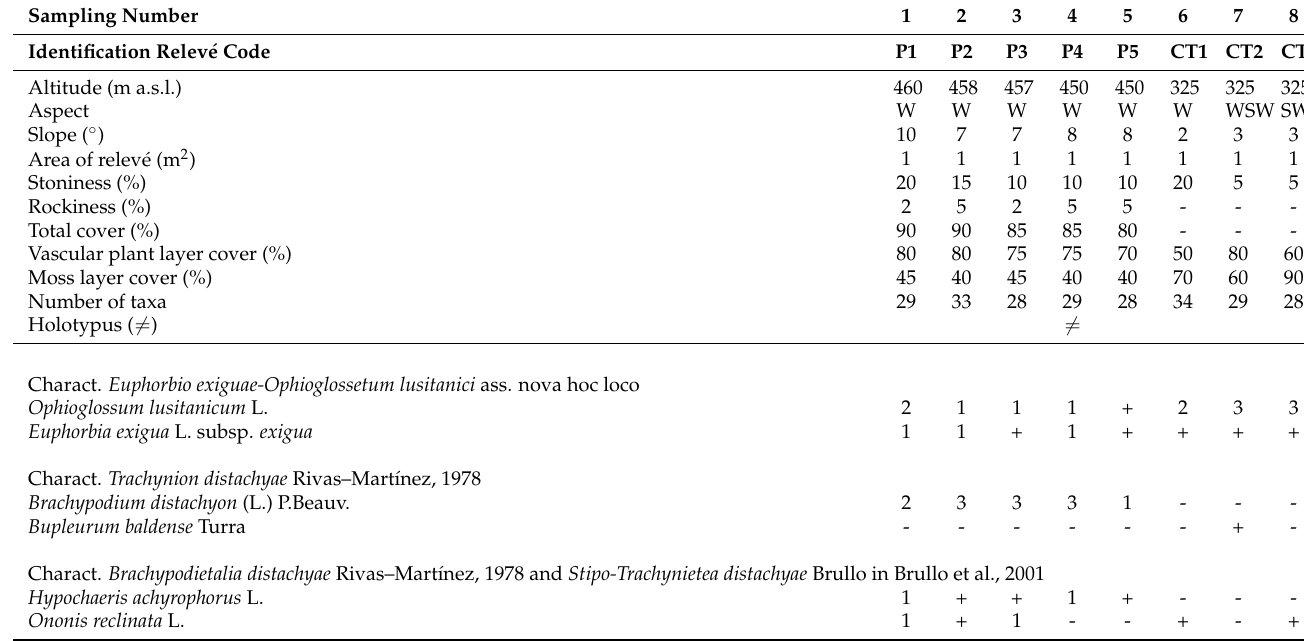
Figure 4. Biplot of the principal component analysis in the first two principal components space of the vegetation relevés (T1–T2: Tuscany; S1–S5: Sicily; CV1–CV6: Campania–Mt. Vesuvius; CT1–CT3: Campania–Tifatini Mts.; P1–P5: Apulia); light gray circles indicate taxa whose names are not reported to improve the readability of the figure. Table 1. Euphorbio exiguae-Ophioglossetum lusitanici ass. nova hoc loco. Further details of relev é s and sporadic species are reported in Appendices A and B,